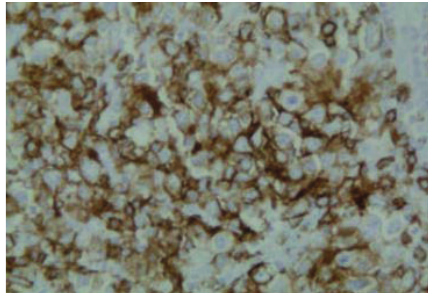
Figure 7: CD 79a positivity suggestive of DLCBL (100x).